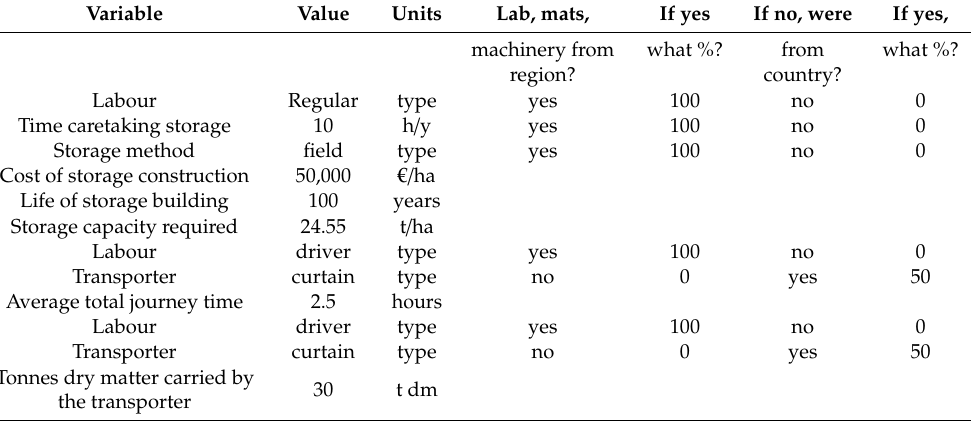
Table A3. Feedstock production data: Crop / Biomass storage and transport to the conversion